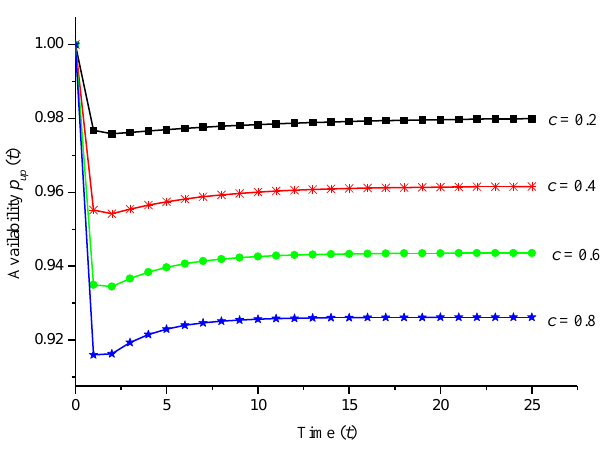
Figure 5. Availability of the system with